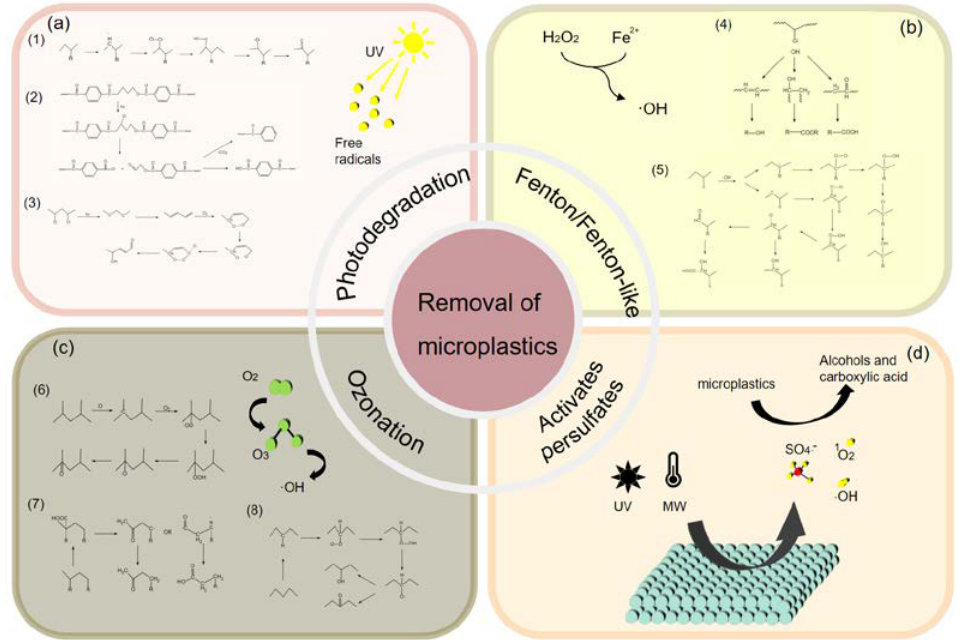
Figure 4. ( a ) Degradation pathways of microplastics during photodegradation; (1) PS and PE under ultraviolet light exposure(R is a benzene ring, H) [87]; (2) the degradation pathway of PET under ultraviolet light exposure [88,89]; (3) the degradation pathway of PVC under ultraviolet light exposure [90]. (b) Degradation pathways for microplastics during the Fenton/Fenton-like process; (4) degradation pathway of PVC under Fenton conditions [91]; (5) degradation pathway of PS under Fenton conditions (R is benzene ring) [92]. ( c ) Degradation pathways of microplastics during ozonation; (6) ozonation degradation pathway of PP [93]; (7) polystyrene (PS) ozonation degradation pathway [94]; (8) PE ozonation degradation pathway [95]. ( d ) Activation of the mechanism of action of persulfates.